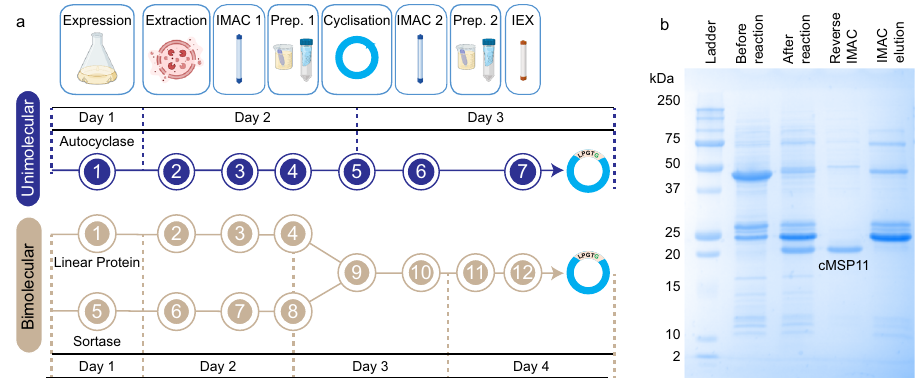
Fig. 3 Simpli fi cation of enzymatic head-to-tail cyclisation using autocyclases. a A fl owchart outlining each distinct step in the process, comparing autocyclisation with the previously described bimolecular reaction 8 . Preparation step 1 (Prep. 1) differs between the two methods. In the unimolecular reaction, this step involves dialysis of the fusion protein into a suitable solution for TEV cleavage and cyclisation reactions, which are performed as a single step (5). In the bimolecular reaction, this step (4) includes the TEV cleavage reaction as well as a number of buffer exchange steps (preceding and following this step). Following reverse IMAC puri fi cation (IMAC 2), the sample can be loaded directly onto an ion exchange (IEX) column without the previously described buffer exchange step (Prep. 2). b cMSP11 cyclisation using the proposed method, showing SDS-PAGE lanes corresponding to start and end of steps 5 and